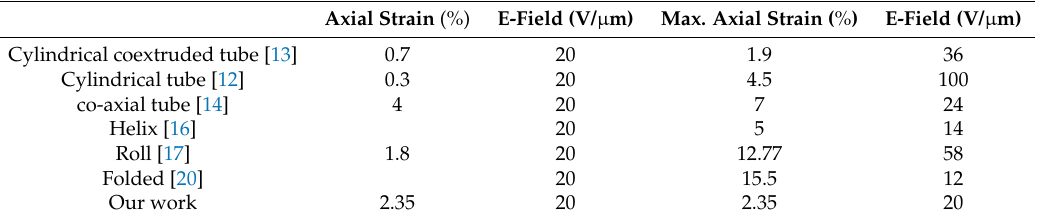
Table 3. Comparison of axial deformations in various existing DEA